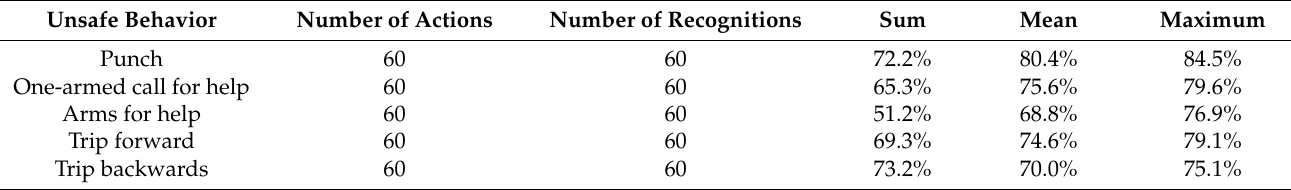
Table 9. Local “adjacent joint method” identification results.